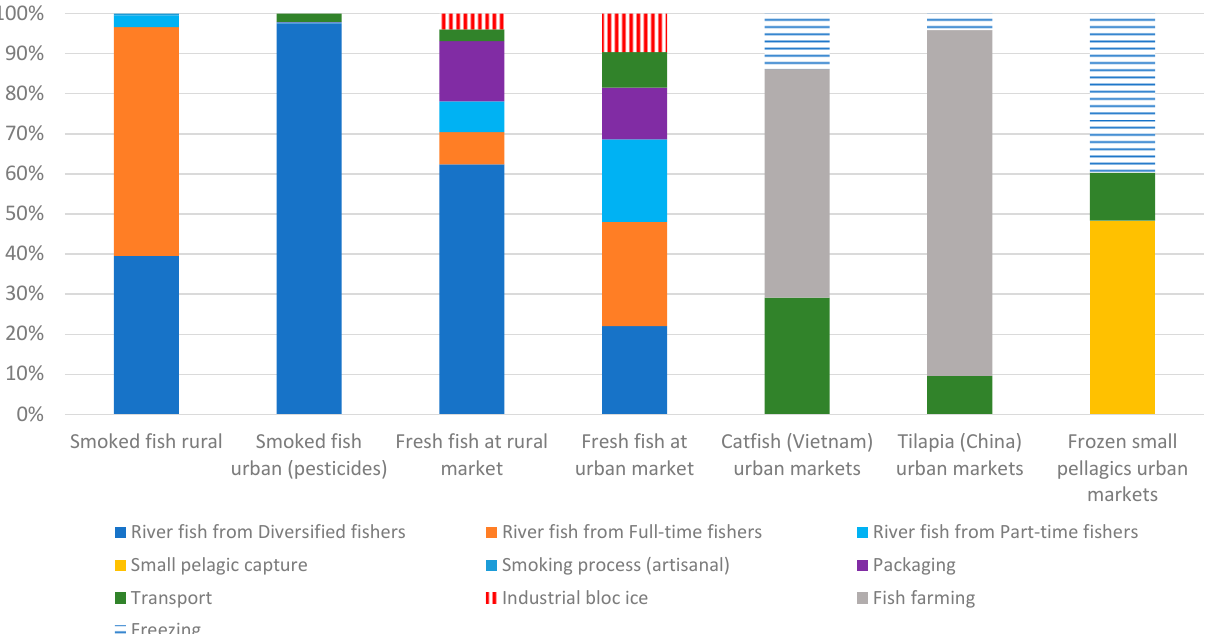
Figure 5. Contribution analysis of Malian transported fresh fish, processed fish products and imported fish products per t of product and relative to a single